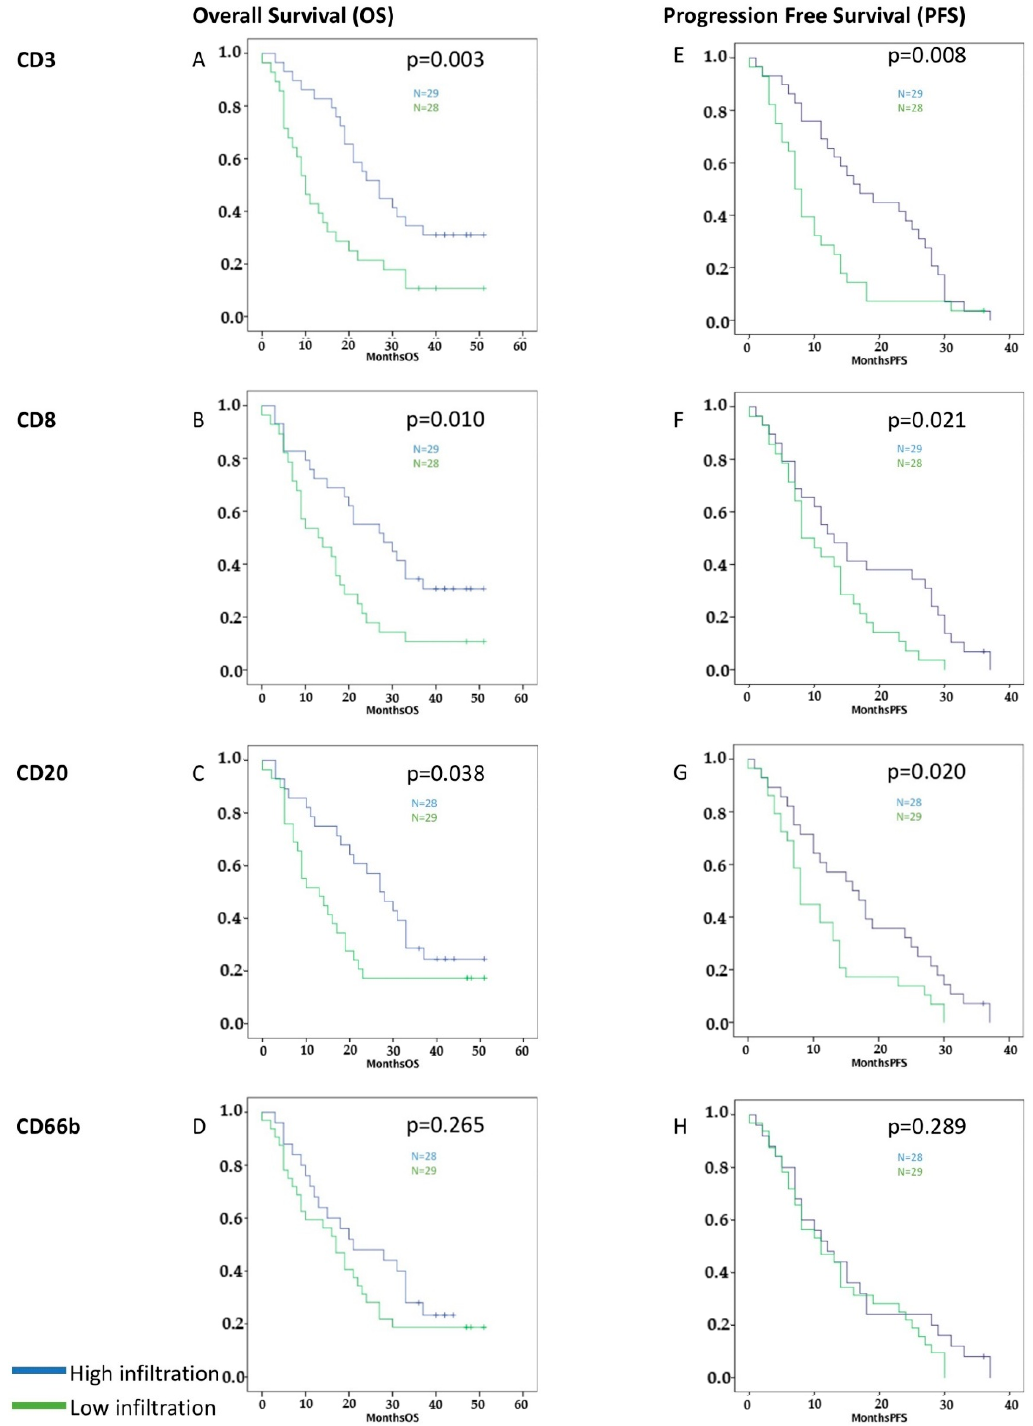
Figure 1. Survival graphs of overall ( A – D ) and progression-free survival ( E – H ) for high (blue) vs. low (green) infiltration of CD3 + , CD8 + , CD20 + , and CD66b + tumor-infiltrating leukocytes (TILs). The median value was used to distinguish high vs. low infiltration after quantification of stained cells [39]. High infiltration with CD3 + , CD8 + , and CD20 + TILs correlated significantly with improved OS and PFS. No statistically significant influence was evident for CD66b + TINs.